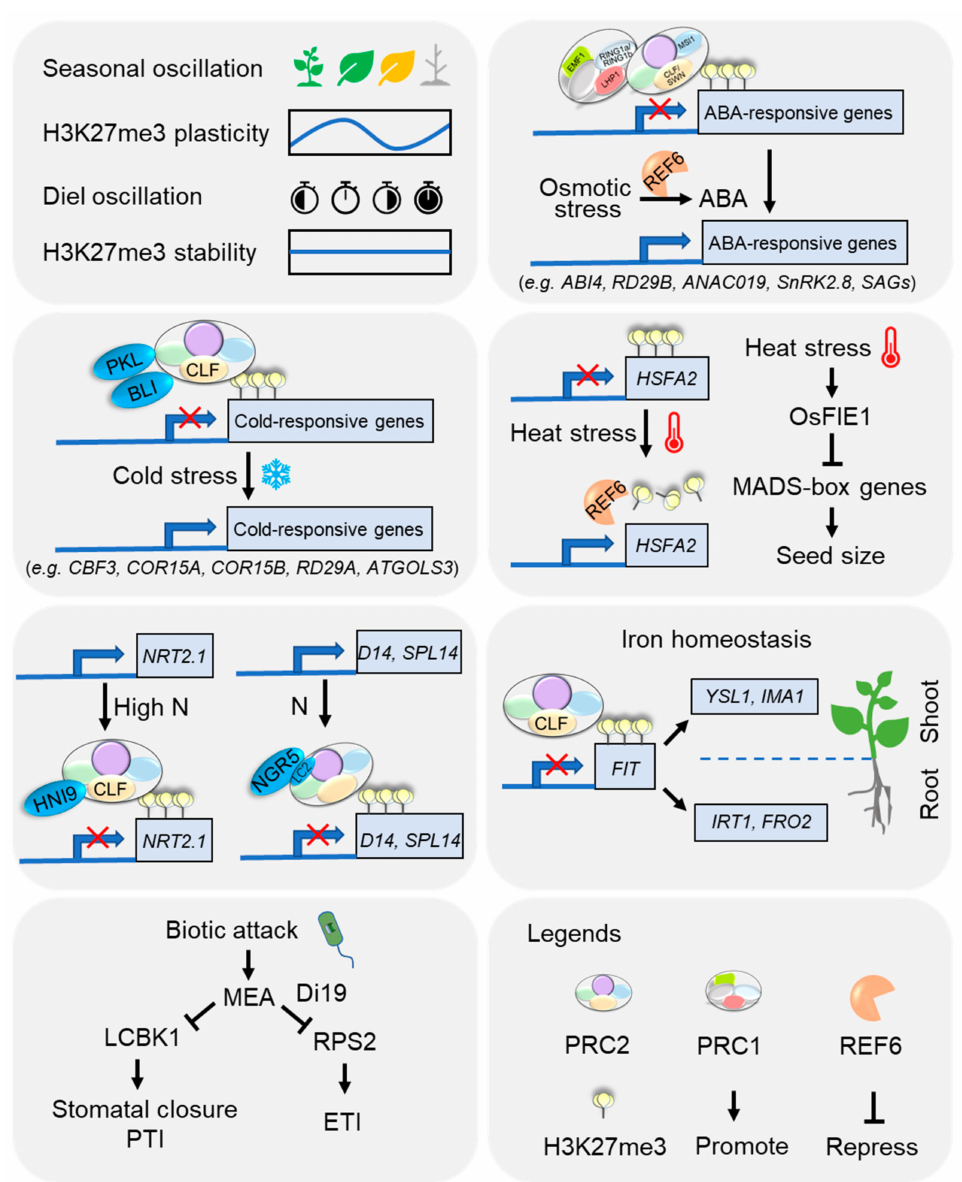
Figure 3. Scheme summarizing current understanding on the roles of H3K27me3 in plant adaptation to environmental cues. Acronyms and further details are explained in the